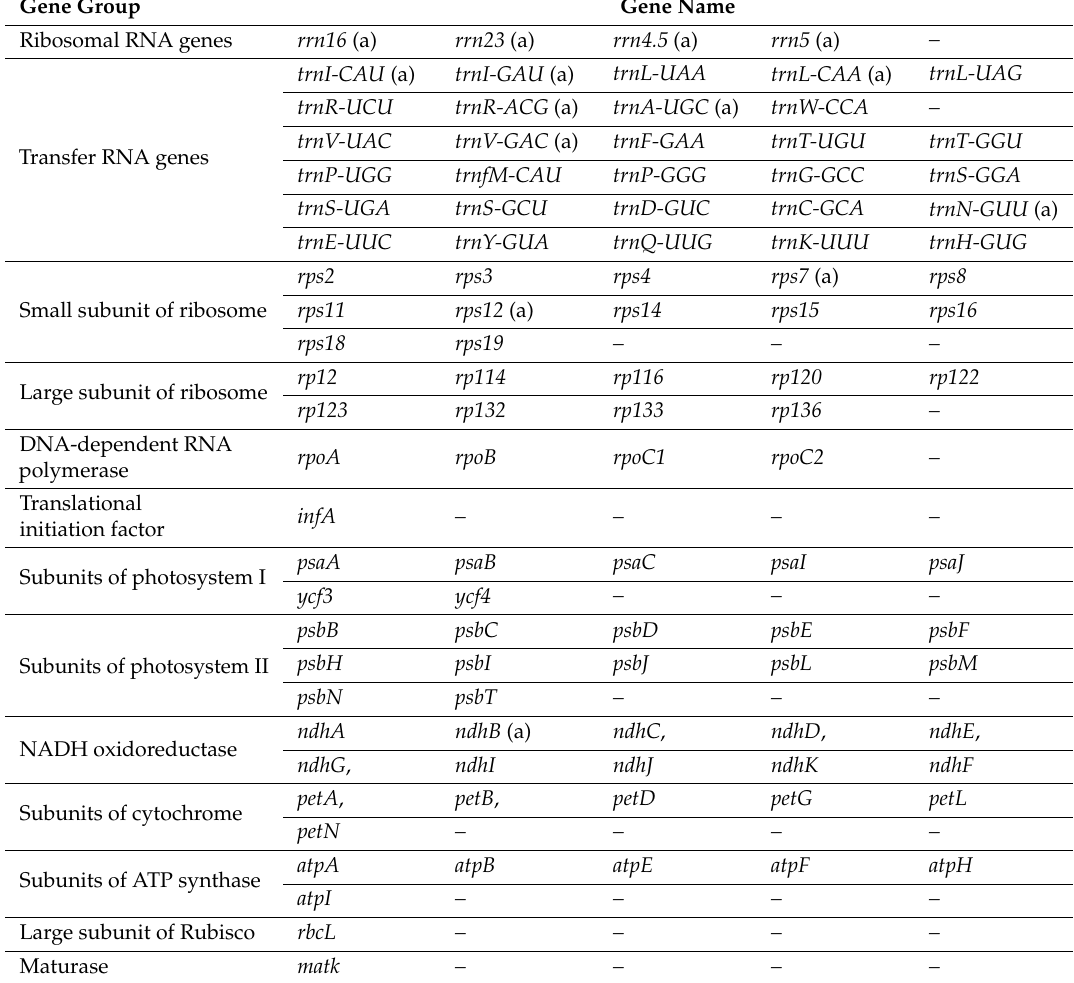
Table 2. List of genes present in the chloroplast genomes of seven Lonicera species. Gene Group